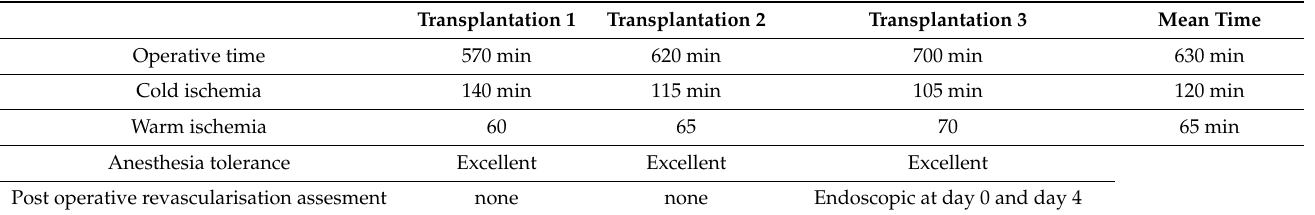
Table 1. Operative time, ischemia times, tolerance and post-operative revascularisation assessment for the three transplantations.